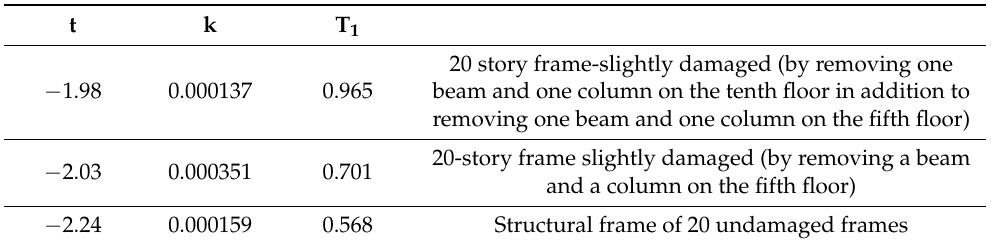
Table 5. Parameters in seismic hazard curves for three different zones.